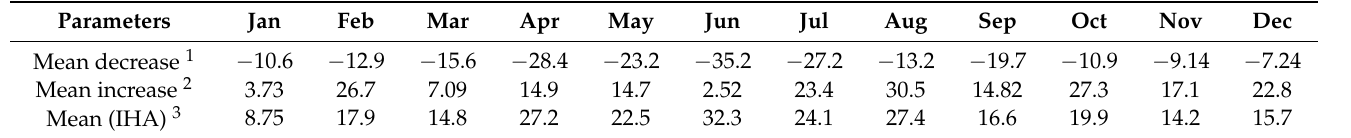
Table 4. Change (%) in the mean monthly flows (group 1 of IHA parameters).